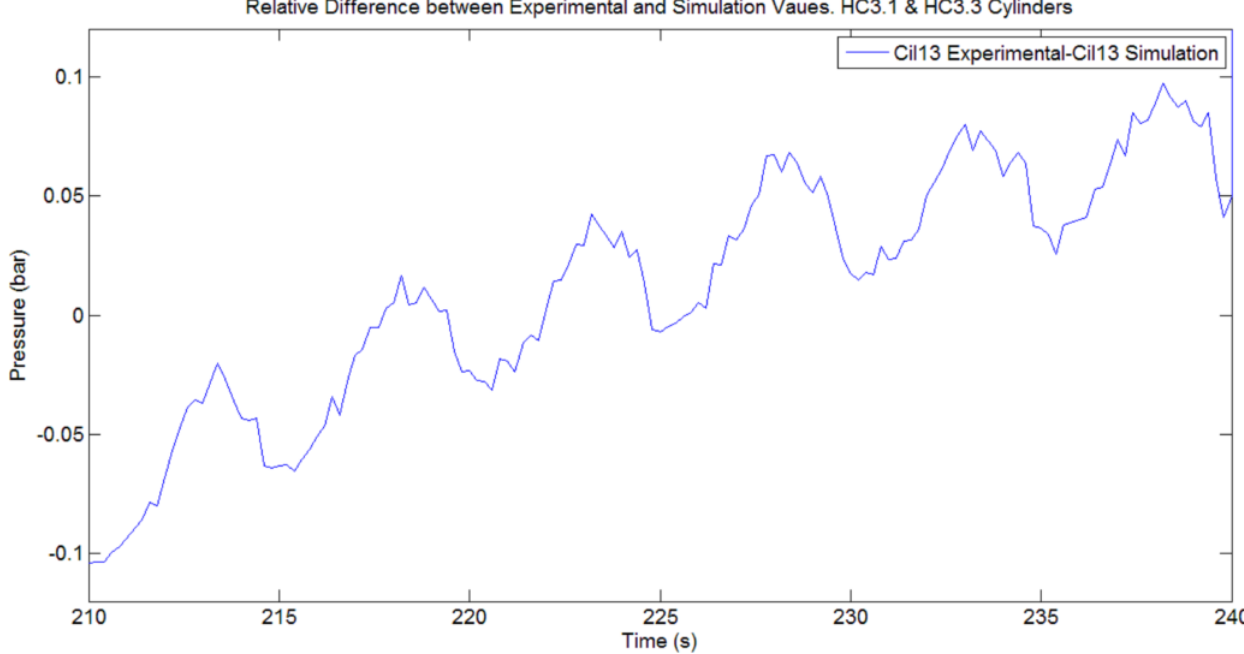
Figure 26. Relative Difference between Experimentally Measured and Simulated pressure of HP Accumulator. Active cylinders HC3.1 and HC3.3. Initial Pres. 64.5 bar. Geometrical layout: Config 1.